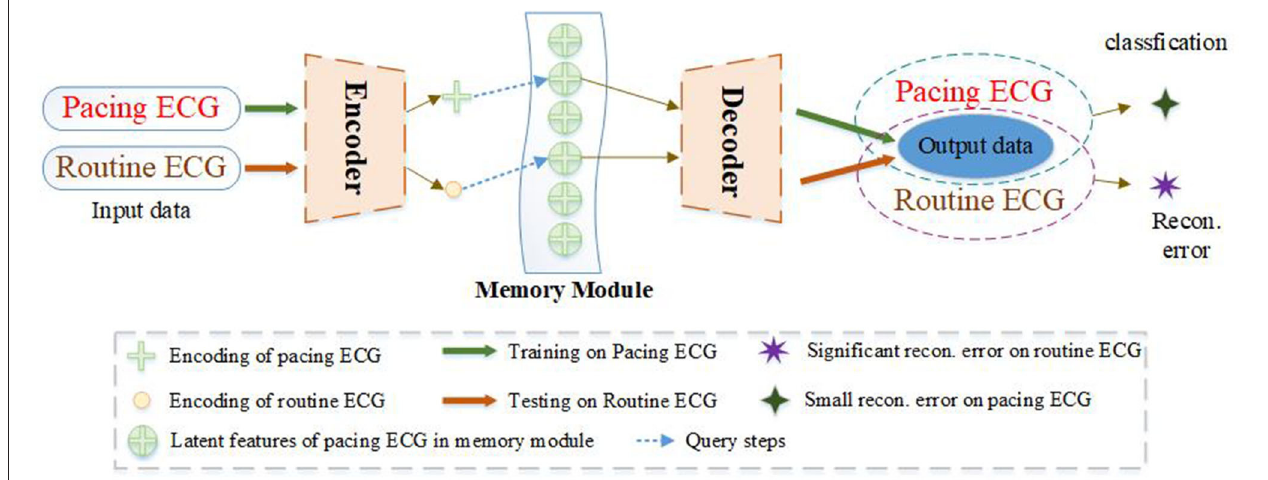
FIGURE 1 | The ECG abnormality detection via the proposed MAE. A sample of training on the pacing ECG database, the memory module records the latent features of the corresponding training ECG type. Given an input sample of other types, the MAE queries the most correlation latent features in the memory module for data reconstruction, resulting in an output significantly different from the input data. But if the input sample belongs to the training type. The MAE can reconstruct very well according to the memory